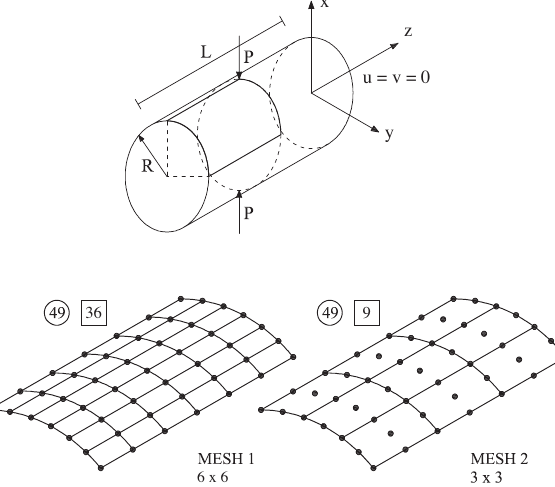
Figure 2: Numerical test example 1, a pinched cylinder: geometrical representation and FE discretization in the following cases: 4 and 9-nodes elements (6 and 3 elements per side